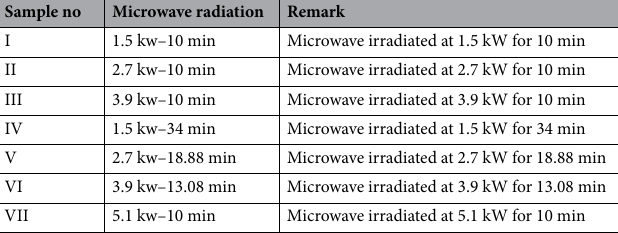
Table. 1. Microwave irradiated